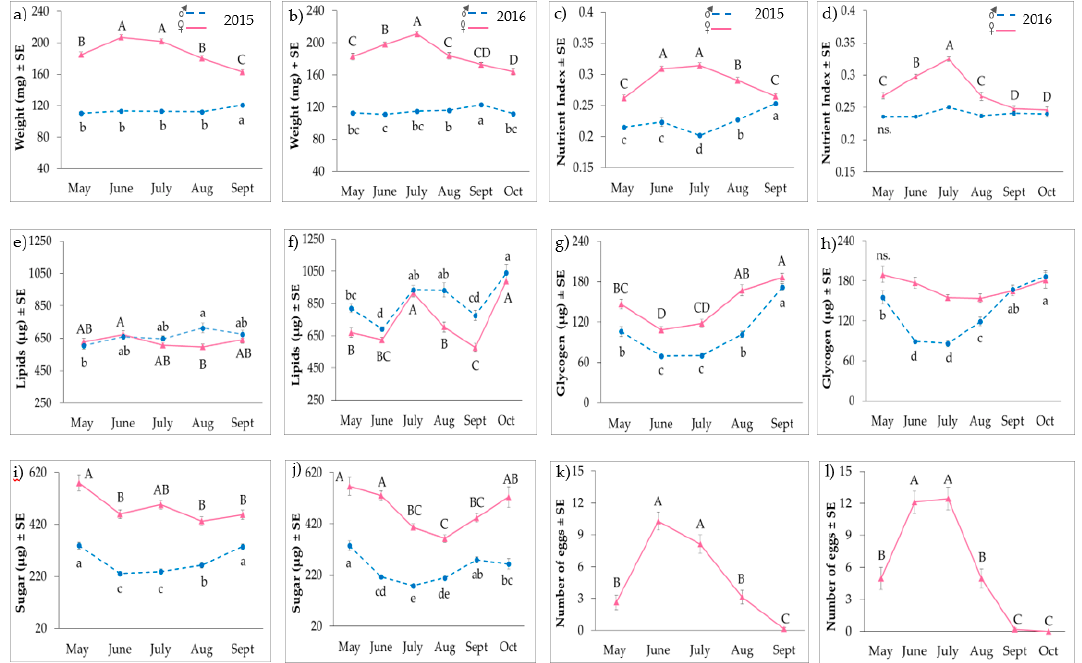
Figure 1. Average ( ± SE) weight ( a , b ); nutrient index ( c , d ); lipid ( e , f ); glycogen ( g , h ); sugar ( i , j ) and egg count ( k , l ) of BMSB adults collected from holly in Oregon in 2015–2016, respectively. Upper and lower case letters indicate monthly differences by Tukey HSD among females and males, respectively. Table 3. The effect of month on weight, nutrient index, lipid, glycogen, sugar and egg of summer female and male adult BMSB in Oregon in 2015–2016, with prothorax as a covariate. Female Year Measurement Effects